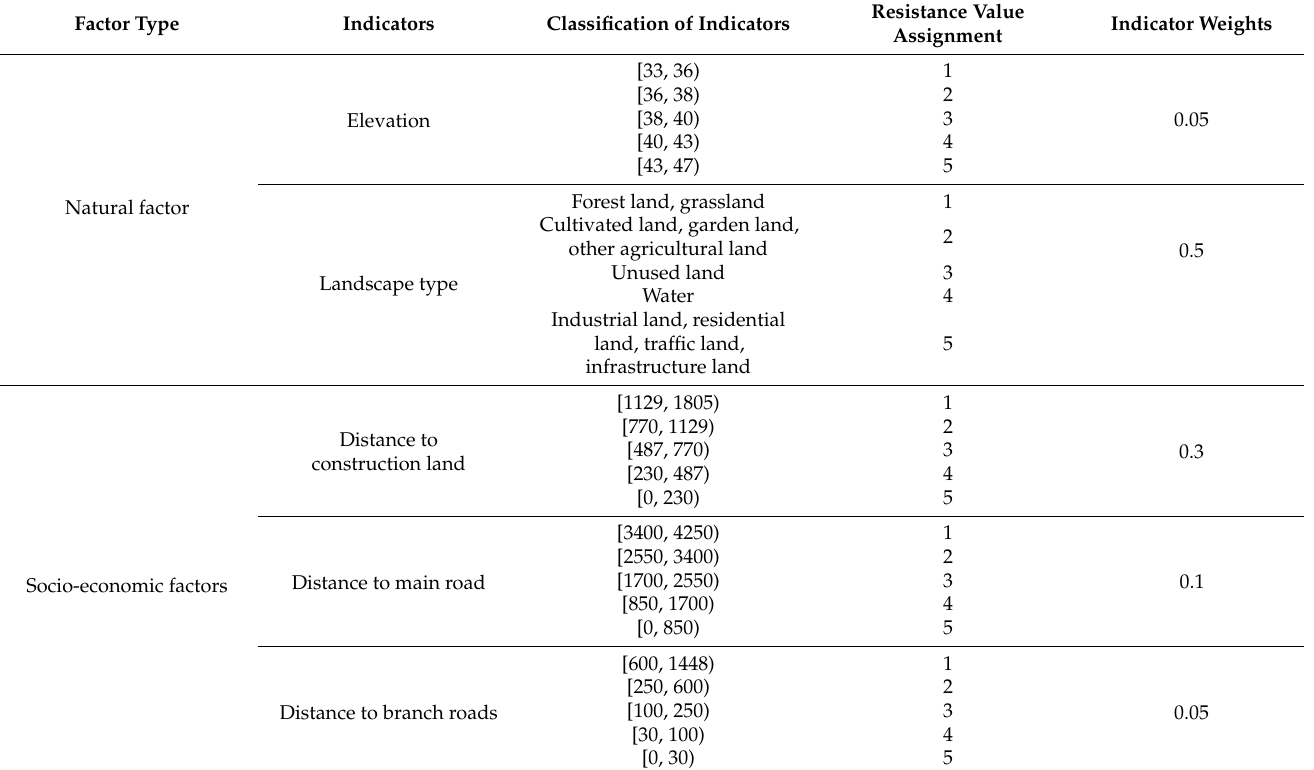
Table 1. The classification threshold, resistance value, and weight of the resistance factor